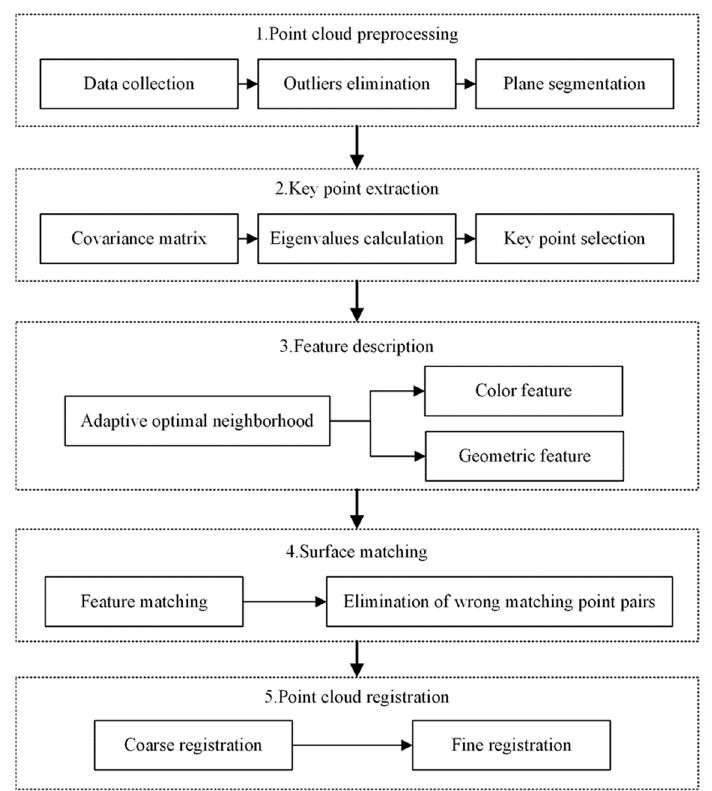
Figure 2. The framework of the proposed approach.